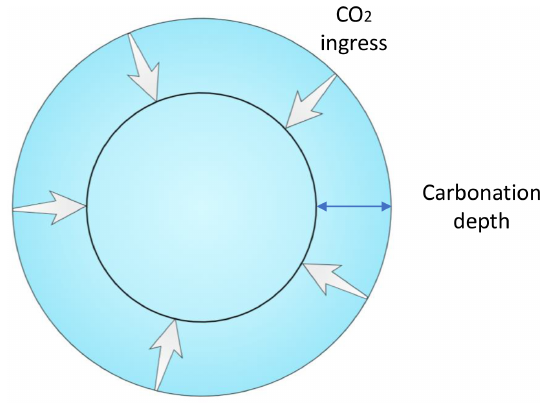
Figure 2. Two-dimensional schematic representation (circular cross-section) of the three-dimensional “sphere” carbonation model of a concrete particle in the demolition